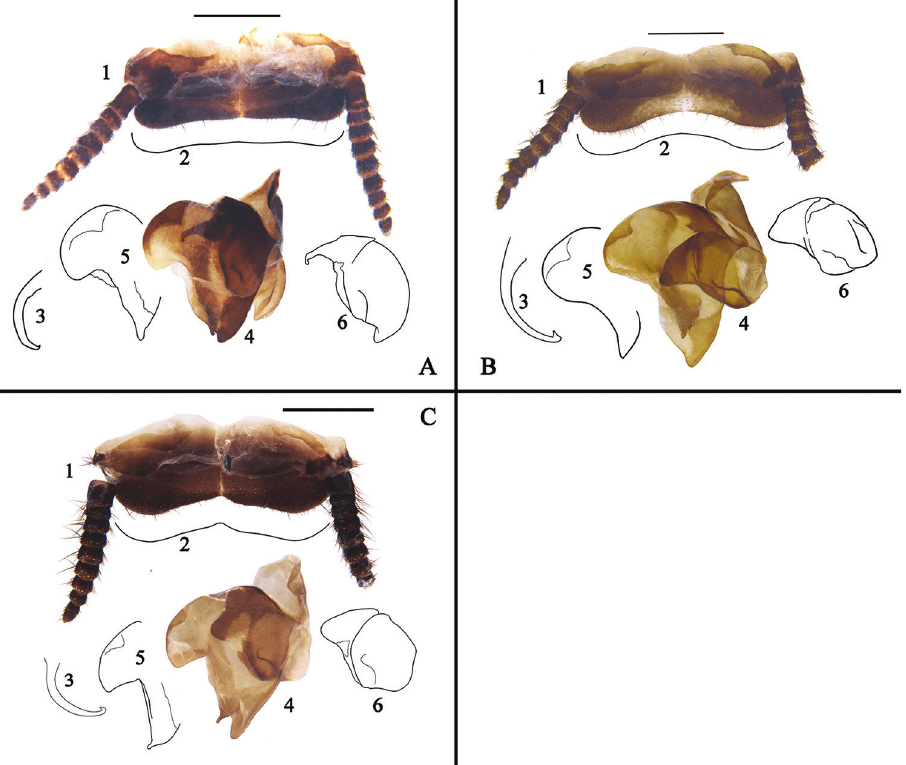
Figure 10. A–C Features of Eucorydia species (supra-anal plate ( 1 ), hind margin of supra-anal plate ( 2 ), genital hook/L3 ( 3 ), right phallomere with L7 ( 4 ), appendage sclerite/L7 ( 5 ), R2 ( 6 )) A E. xizangensis B E. splendida sp. n. C E. tangi sp. n. Scale bars 1 mm. Genitalia (Fig. 10A): L3 slender, strongly curved, apex thinner; appendage sclerite narrow, base enlarged, round, left portion roundly protruded, distal portion elongate, apex bud-like protruded; R2 with an elongate irregular process on the left, apex of the process curved. Female